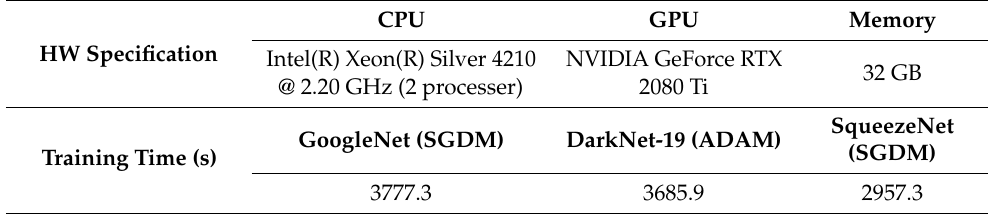
Table 4. Hardware specification and training time.